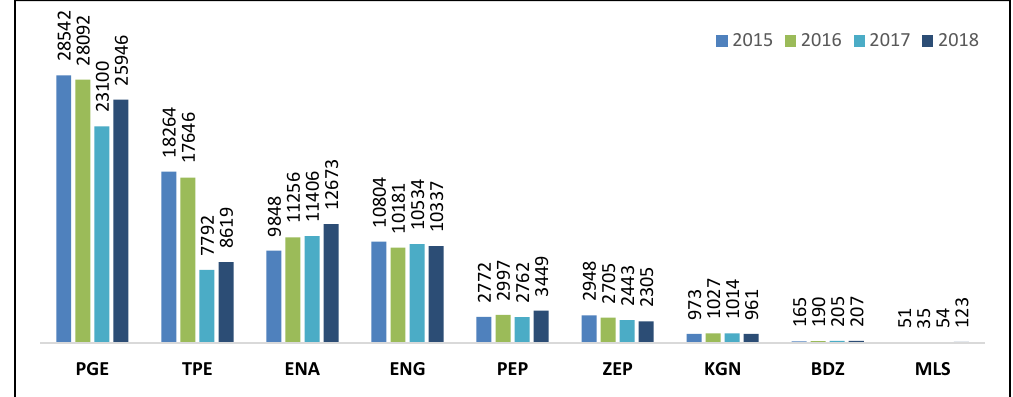
Figure 2. Sampled companies according to sales revenues (in mln of PLN).